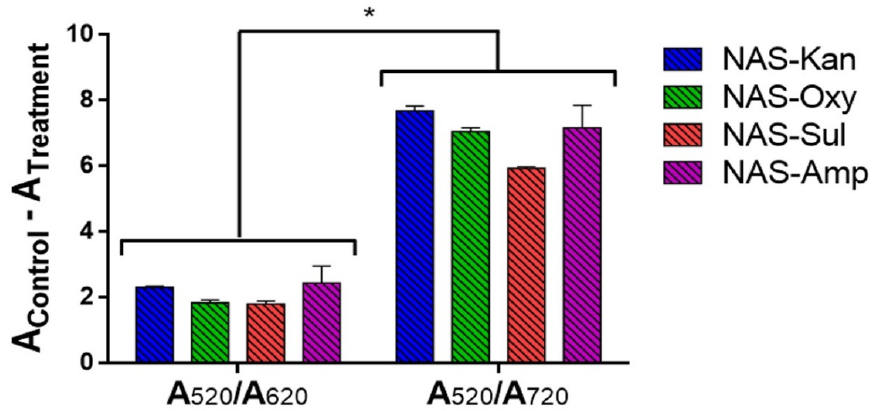
Figure 3. Comparison of the absorption ratios A 520 /A 620 and A 520 /A 720 from spectral variation associated with the aggregation of AuNPs as a colorimetric signal generated by the NAS in the detection of kanamycin (blue), oxytetracycline (green), sulfadimethoxine (red) and ampicillin (purple). Treatments correspond to antibiotic-containing samples at the MRL concentrations of each antibiotic, while controls include nanopure water instead of antibiotics. The absorbance readings were transformed according to Equation (1). Results were averaged from 3 to 5 independent experiments. Data were analyzed using a nonparametric Mann–Whitney U test. Asterisks denote statistically significant differences between the treatments and controls. * = p < 0.05.